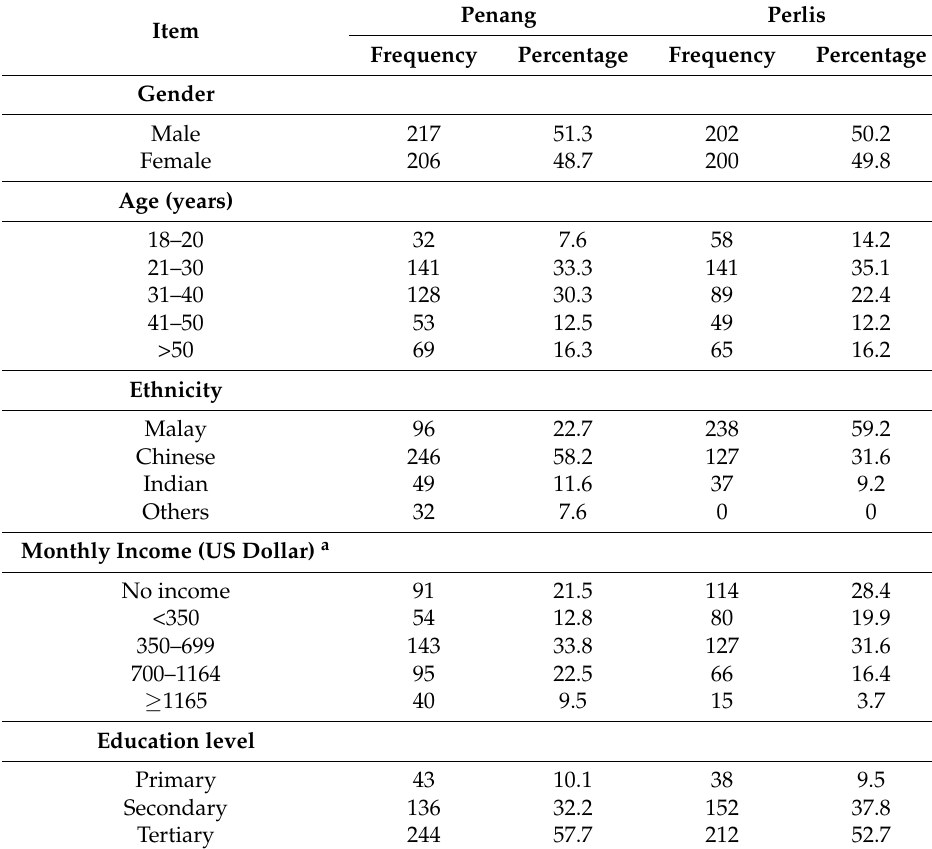
Table 2. Demographic profiles of the